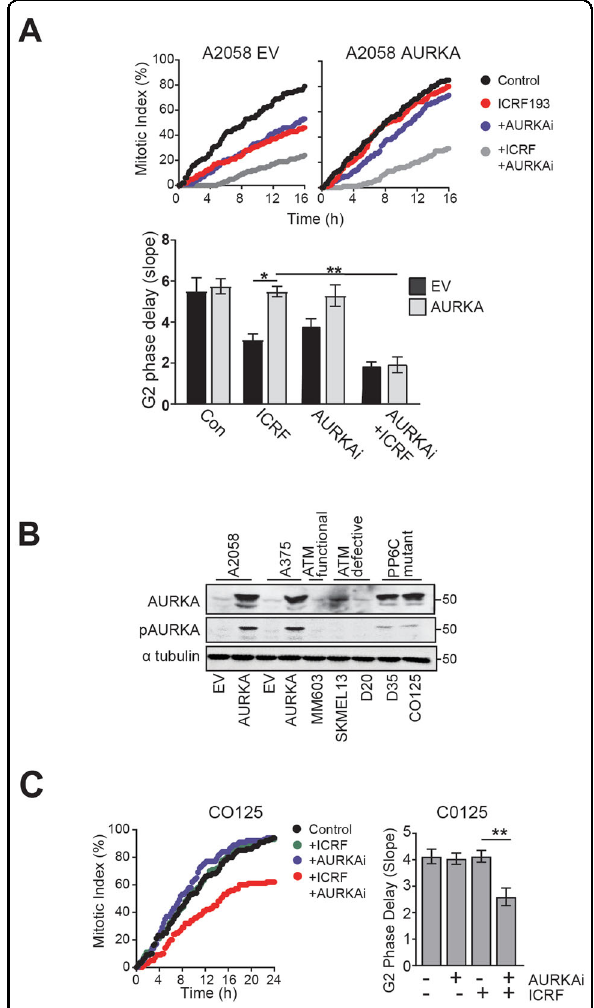
Fig. 1 AURKA over-expression overcomes the ATM-dependent G2 phase checkpoint arrest. A A2058 EV and AURKA overexpressing cells were treated with either 5 μ M ICRF193 or DMSO control. 200 cells were counted for each experimental group. Cumulative mitotic index was assessed as an indicator of G2 phase delay. The bar graph shows G2 phase delay quanti fi ed as the slope of the cumulative mitotic index curve using ICRF193 and 1 μ M AURKA inhibitor (AURKAi) MK5801, as single and combination treatments, or DMSO. B Immunoblot of the level of AURKA and pAURKA in a panel of melanoma cell line (MM603 is ATM checkpoint functional, SKMEL13, D20 are ATM checkpoint defective, C0125 and D35 are PP6C mutants). α -tubulin was used as a loading control. C Bar graphs of the G2 phase delay of C0125 cells treated with ICRF193, AURKAi alone, or in combination. Bars represent means of three independent experiments (±SD); ** p < 0.01; * p <